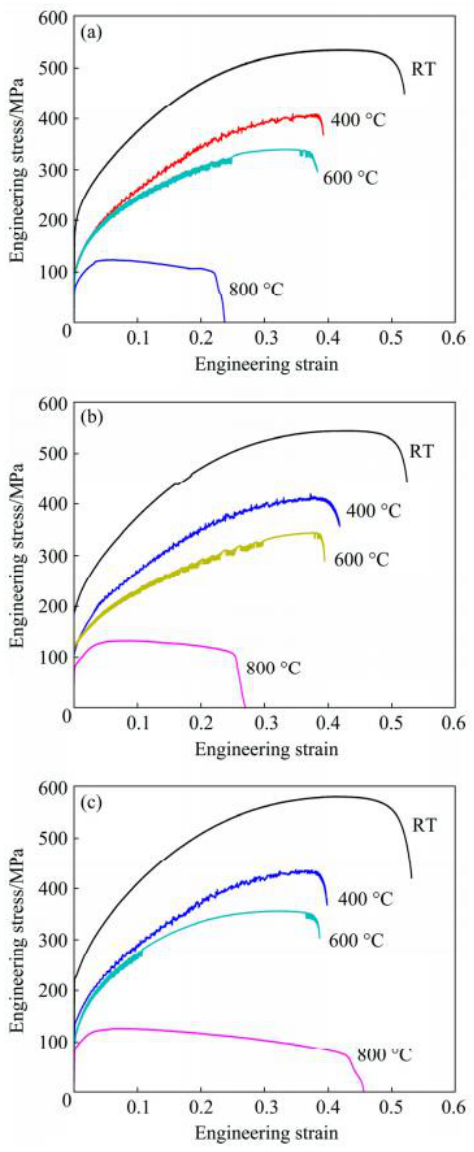
Figure 38. Graphs of the engineering stress–strain behavior for the recrystallized (900 °C, 1 h) and cold-rolled CoCrFeMnNi HEA with a rolling ratio of ( a ) 40%, ( b ) 30%, and ( c ) 20% (reproduced from Reference [168] with permission).